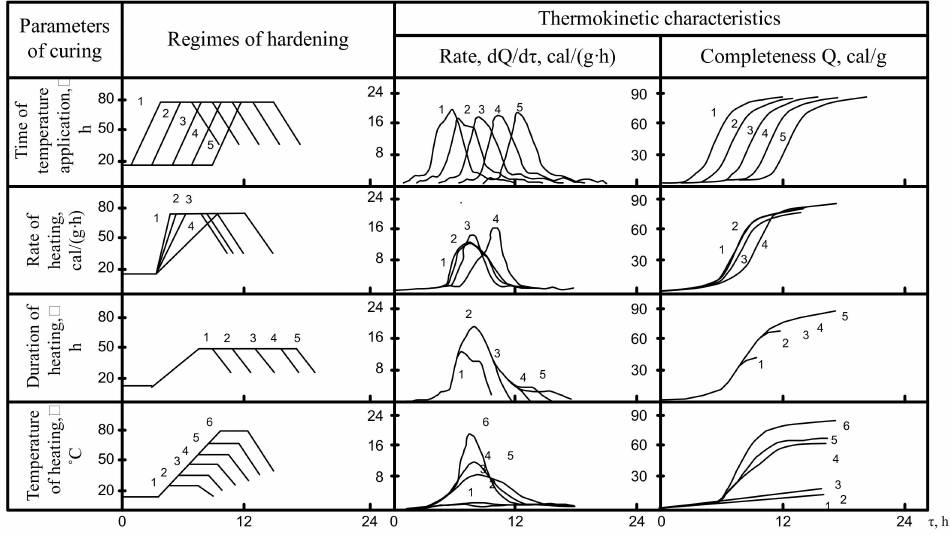
Figure 6. The influence of heat curing parameters on thermokinetic characteristics of the cement hydration in the slag + solution of Na 2 O · SiO 2 · 5H 2 O